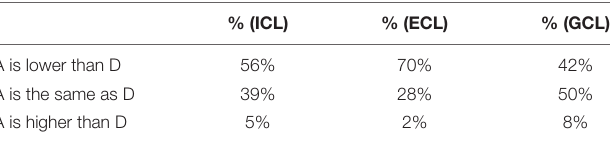
TABLE 6 | Percentage of each option selected by participants for each aspect of cognitive load for (A,D) comparison. % (ICL) % (ECL) %